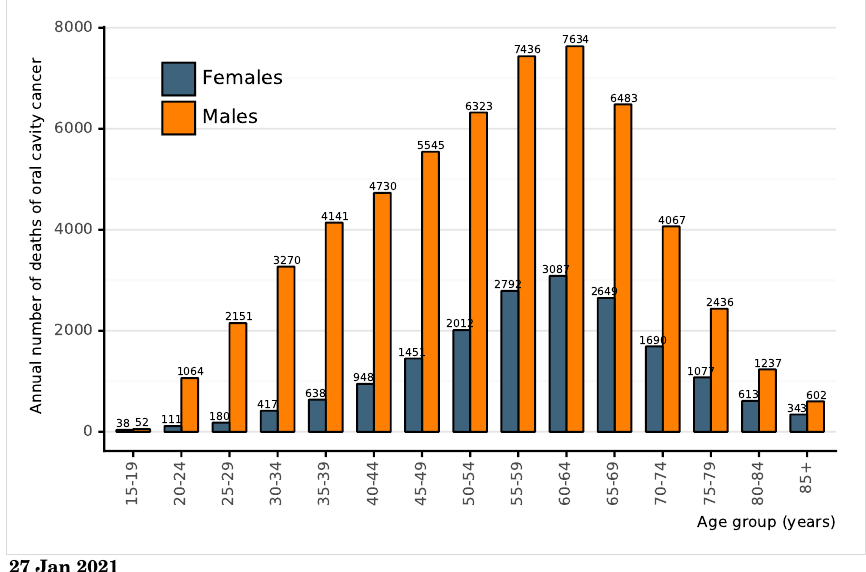
Figure 45: Annual number of deaths of oral cavity cancer in India (estimates for